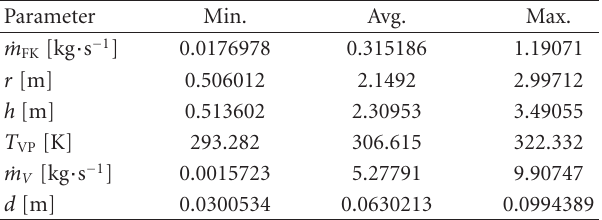
Table 14: Estimated parameters for SA